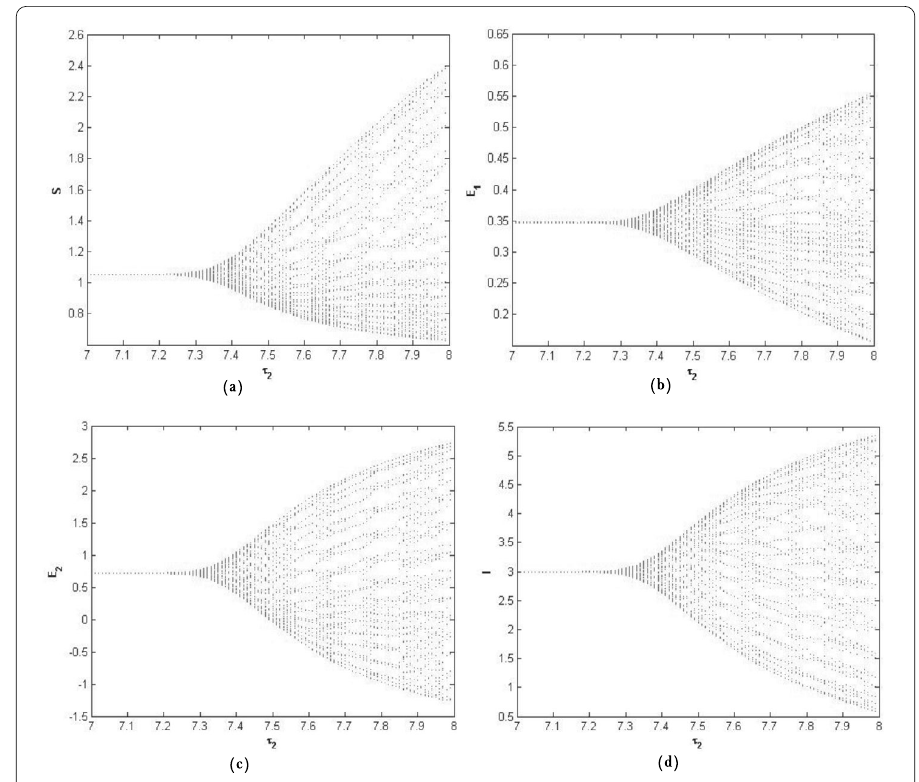
Figure 2 The bifurcation diagram with respect to τ 2 when τ 1 =